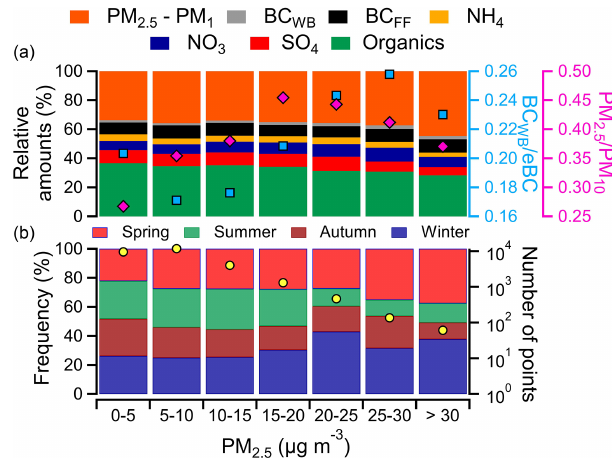
Figure 10. Median relative contribution of chemical composition to different PM 2 . 5 concentration bins (a) and seasonal frequency, including number of hour points (yellow dots), in each PM 2 . 5 con- centration bin (b) . The ratios of BC WB to eBC (blue squares) and PM 2 . 5 / PM 10 (purple diamonds) were also